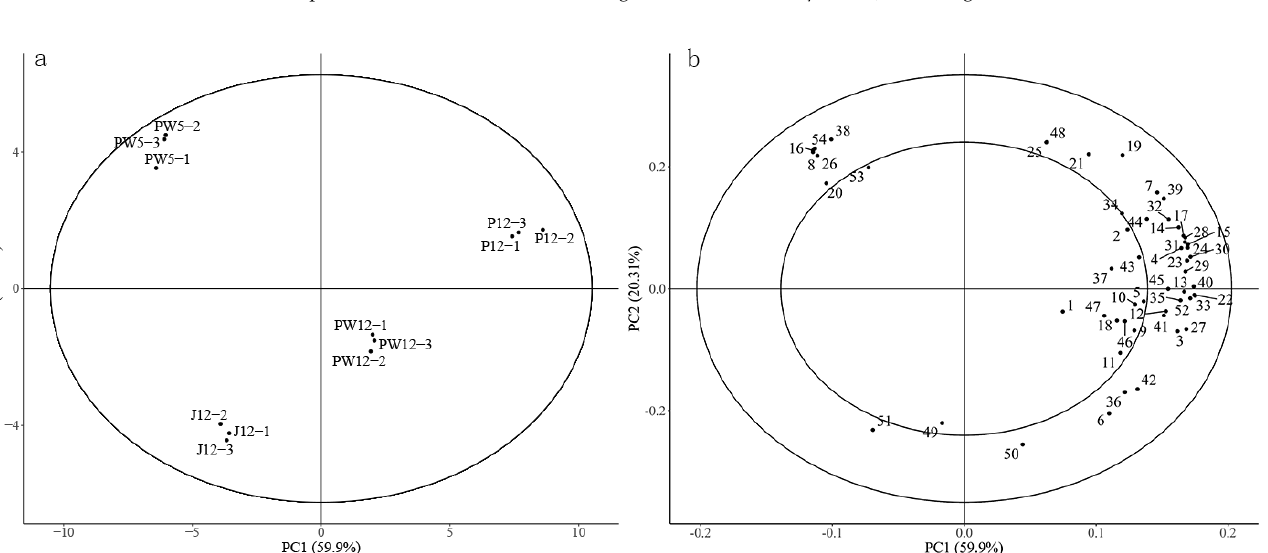
Note: Values are averages of three replicates. Data expressed as mean ± standard deviation (SD). Different alphabets in the same row indicate significant differences ( p < 0.05) according to Duncan test.